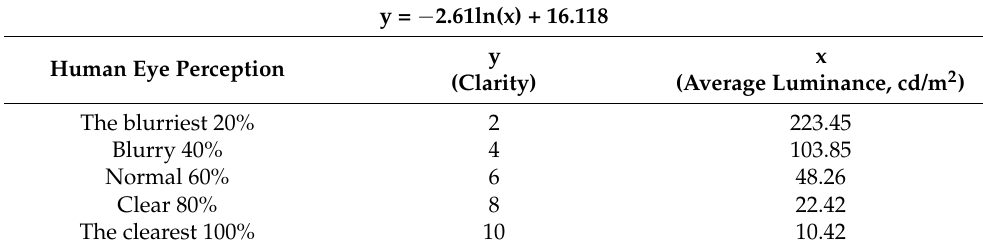
Table 3. Using clarity degrees to calculate average luminance.